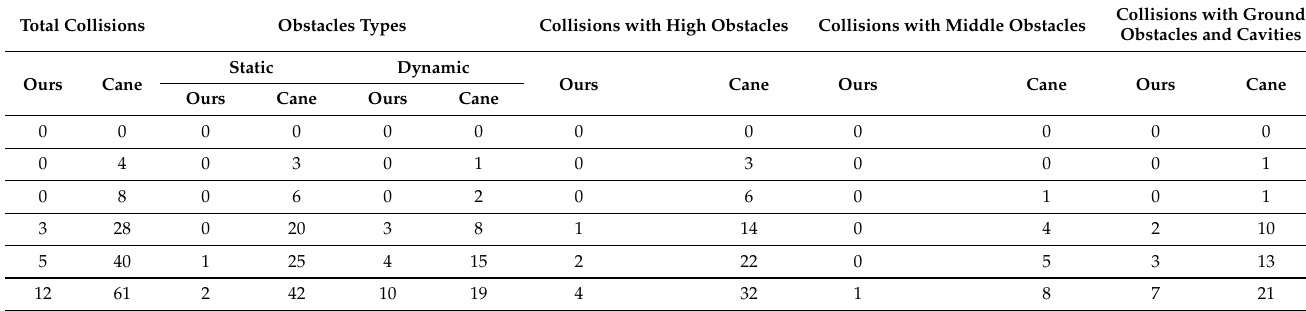
Table 4. Collision with different types of obstacles and comparison with the white cane solution.